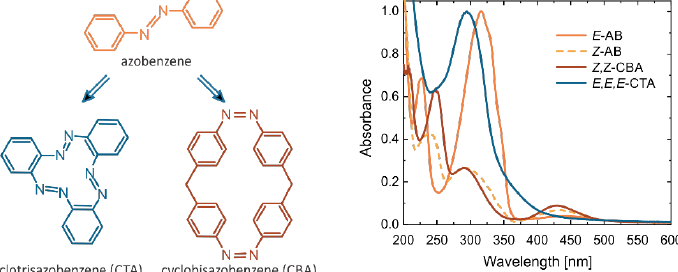
Fig. 1. left : structures of the investigated compounds; right : corresponding absorption